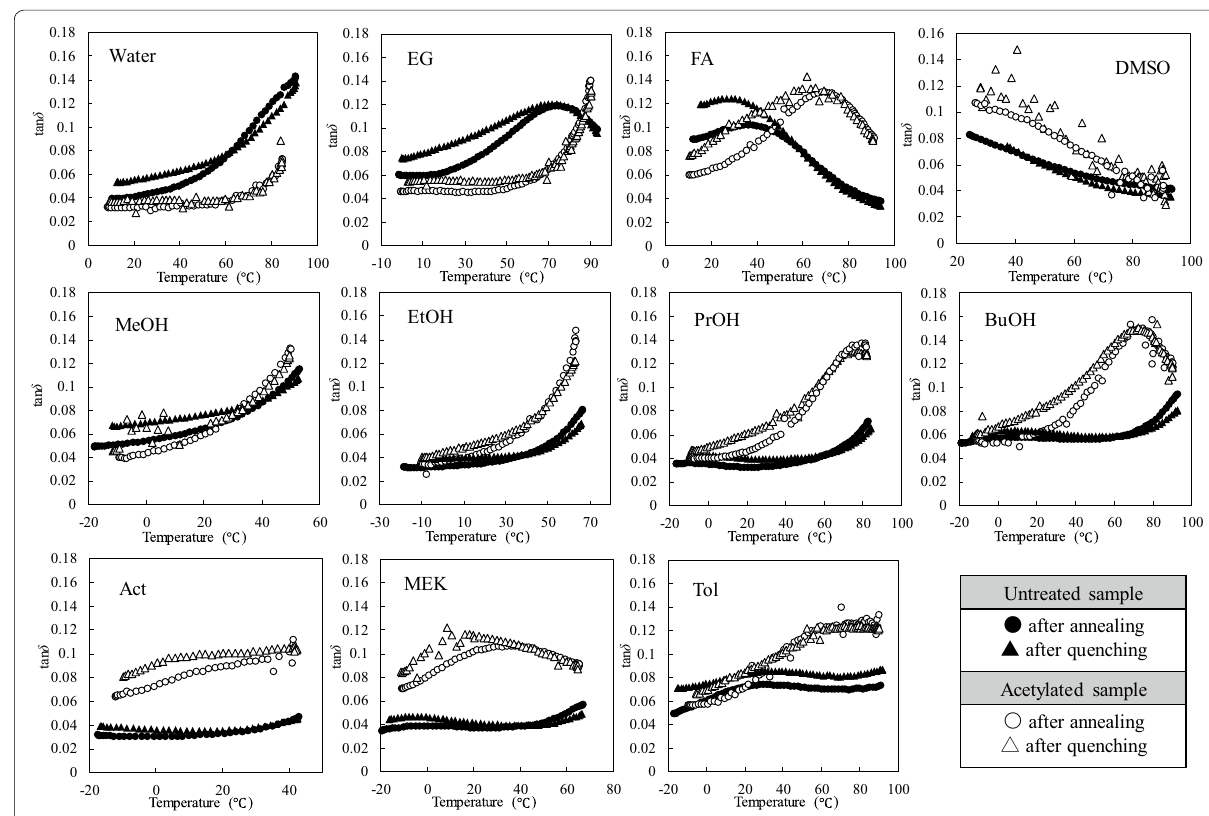
Fig. 3 Temperature dependence of tan δ measured after annealing or quenching process. Filled circles, untreated samples measured after annealing; filled triangles, untreated samples measured after quenching; open circles, acetylated samples measured after annealing; open triangles, acetylated samples measured after